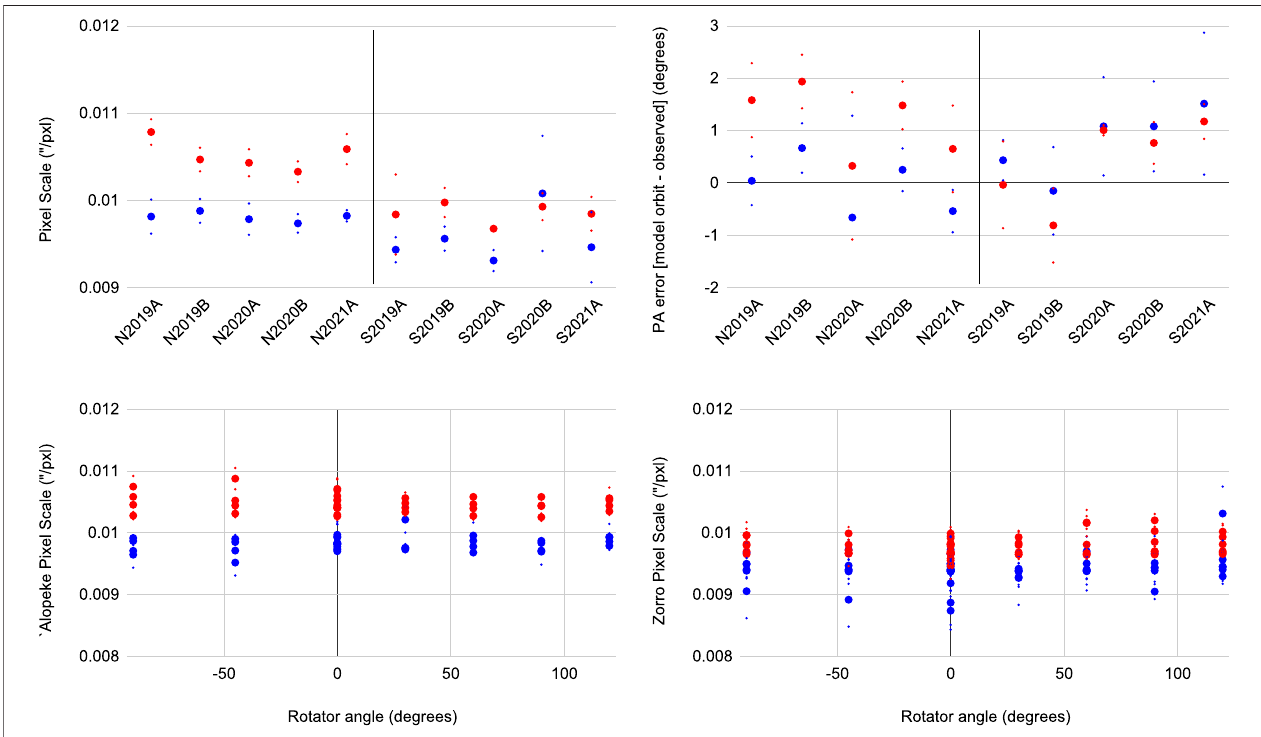
FIGURE 5 | The average pixel scale for each observing semester ( top left ) for ‘ Alopeke and Zorro (pre fi xed with “ N ” and “ S, ” respectively) in the 562 ( blue ) and 832 ( red ) nm fi lters. A single average pixel scale is determined for each observing run and plotted here along with the standard deviation. Top right shows the position angle error found by taking the difference between the predicted companion position angle at time of observation from the measured position angle for each run. The bottom row showsthederivedpixelscaleacrossvariousinstrumentrotatorangles. ‘ Alopekeisshownonthe left andZorroonthe right .Theinstrumentrotatorchangesthe angle of the calibration binary image on the CCD, allowing the pixel scale to be derived at different